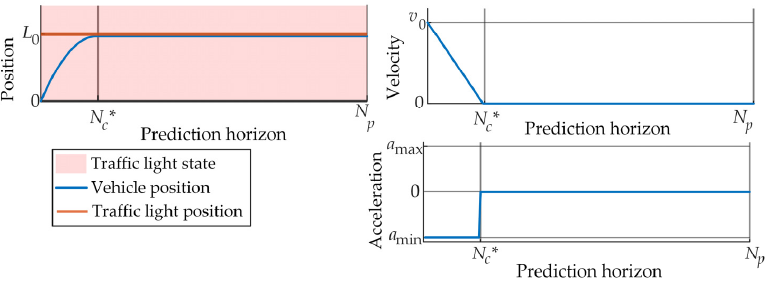
Figure A1. Illustration of the shortest control horizon case for feasible linear MPC with reduced control horizon ( N c << N p ).